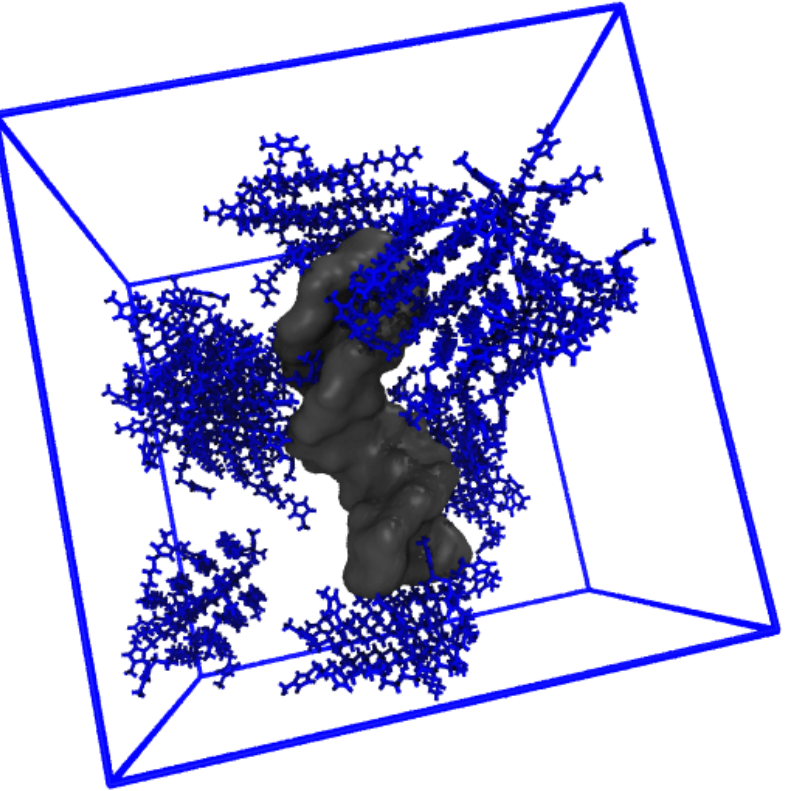
Figure 10. Aggregation of [Im 16,1 ]Cl at 500 mM.